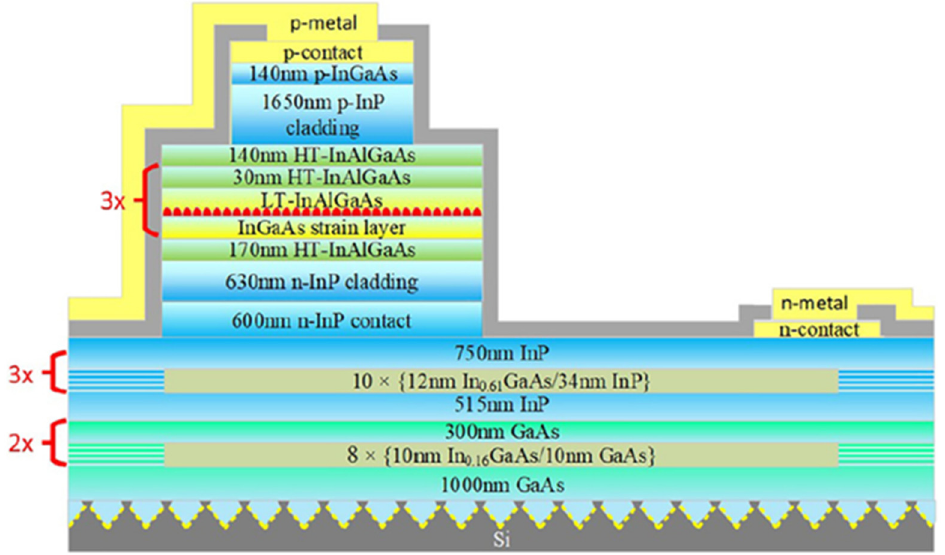
Figure 17. Cross-section schematic of QDash laser on V-grooved (001) Si, including the structural parameters of each epitaxial layer. Reprinted with permission from ref. [75] © AIP Publishing. Copyright 2020 Applied Physics Letters.